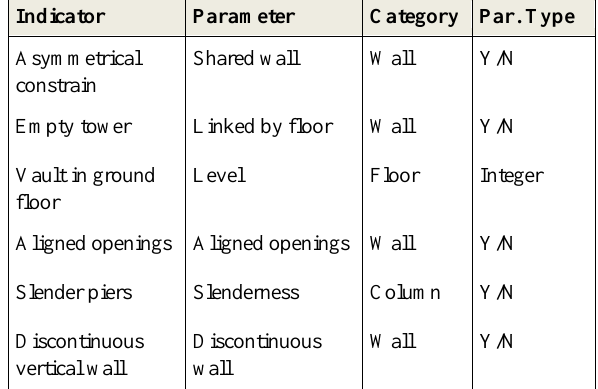
Table 1. The indicator-based parameters settings.